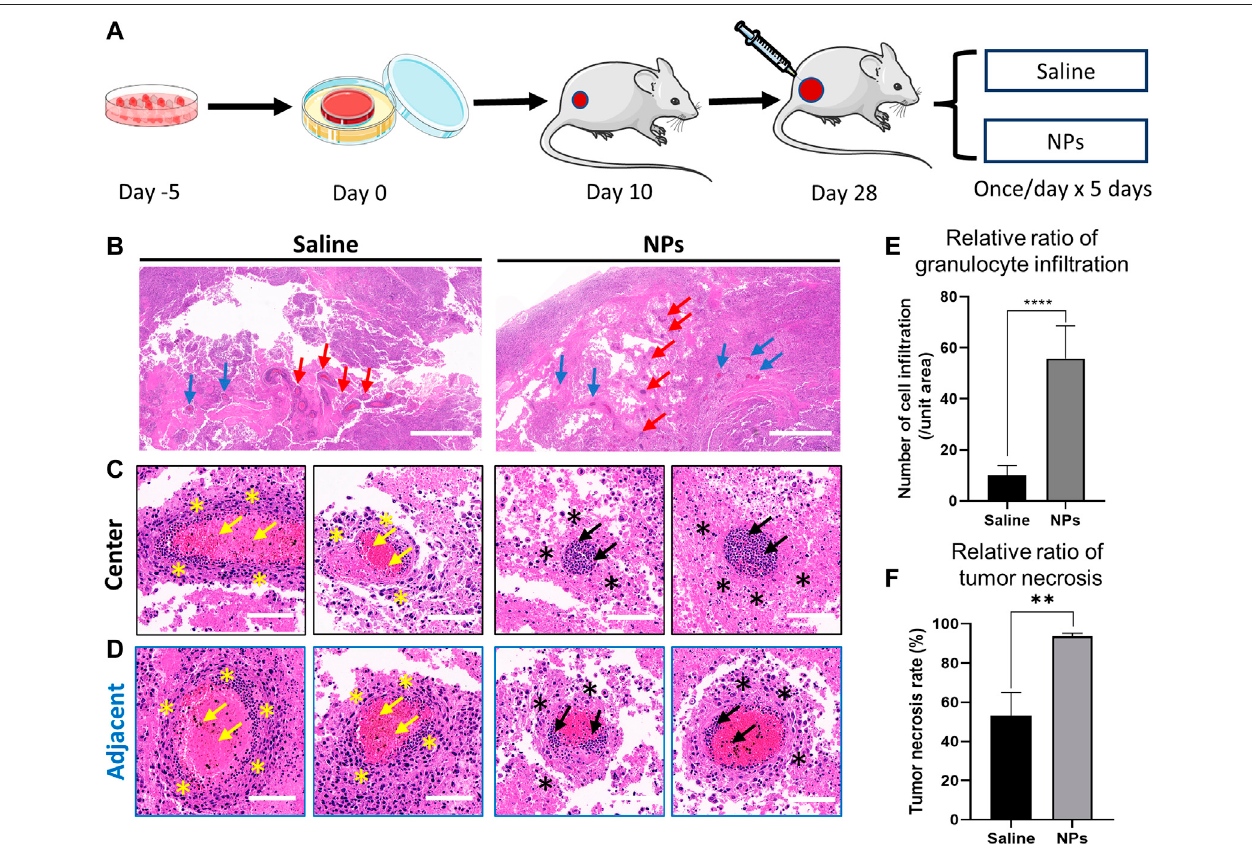
FIGURE5| Nanoparticlesinduceosteosarcomacellnecrosisandvascularin fl ammationinthetumor. (A) Schematicdiagramofnanoparticleandsalineinjectionsin an orthotopic osteosarcoma model. (B) Representative images of H&E staining after intra-tumor injection in the saline and nanoparticle groups. Red arrows indicate the central area of the injection. Blue arrows indicate the adjacent area of the injection. Scale bar = 1 mm. (C, D) H&E staining of granulocyte in fi ltration around the vascular space in the central and adjacent areas of the puncture site. Yellow and black arrows indicate the granulocyte in fi ltration in the vessel. Yellow and black stars indicate the tumor necrosis around the vessel. (E) Comparison of granulocyte in fi ltration between saline and nanoparticle groups (**** p < 0.0001). (F) Comparison of tumor necrosis around the vessel between saline and nanoparticle groups (** p < 0.01). Scale bar = 100 μ m.